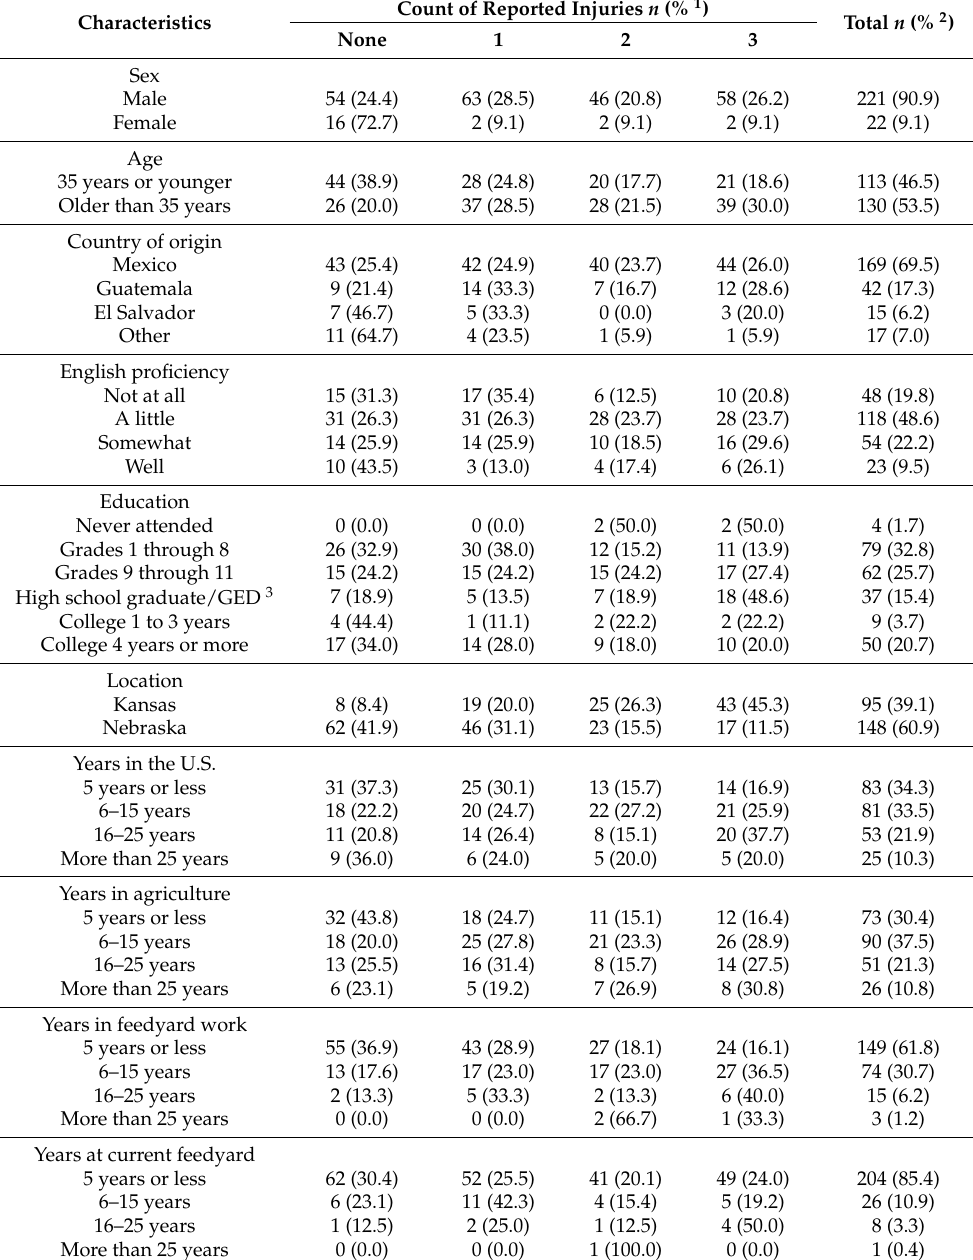
Table 1. Distribution of participants by the number of reported injuries and demographic characteristics.